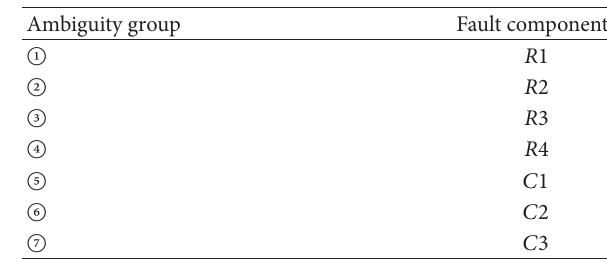
Table 5: Updated ambiguity groups of the Sallen-Key filter by